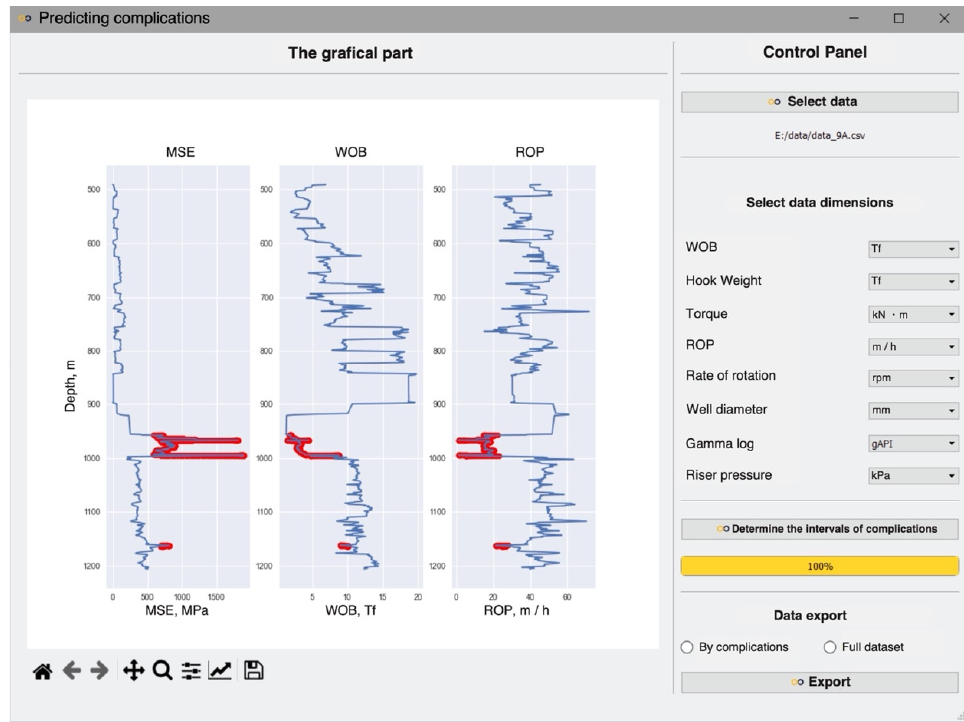
Figure 10. The results of the program based on well data F_9A.